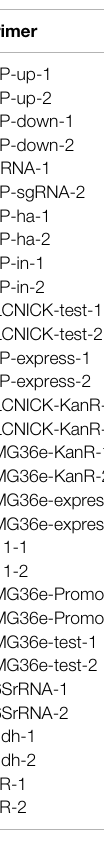
TABLE 2 | Primers used in this